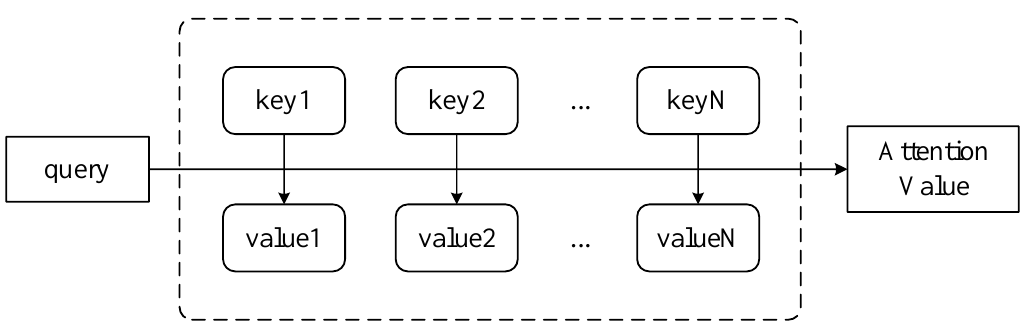
Figure 1. Diagram of the calculation process of attention mechanism.